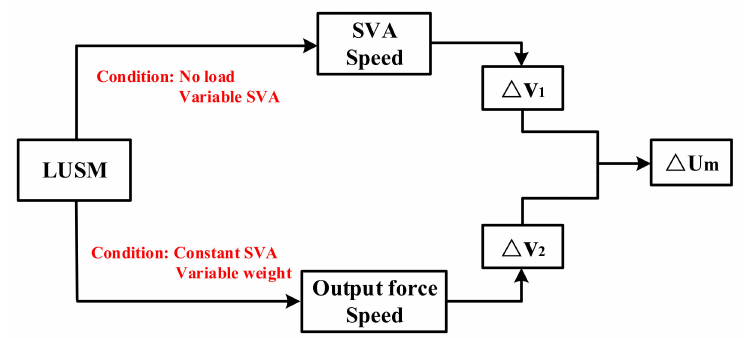
Figure 3. Calculation process of the stator vibration amplitude to be